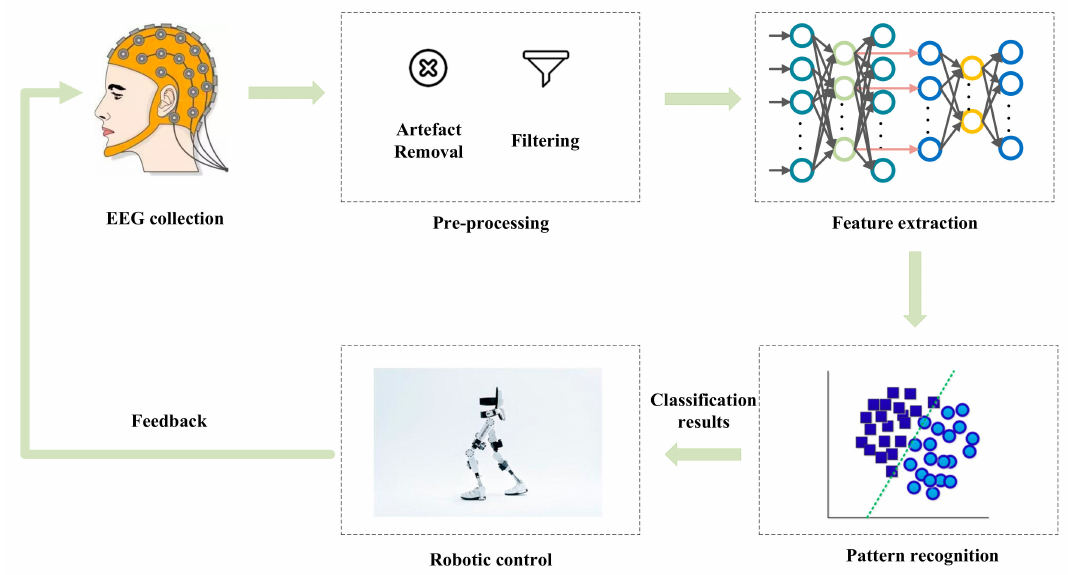
Figure 1. The technical pipeline involved in the BCI